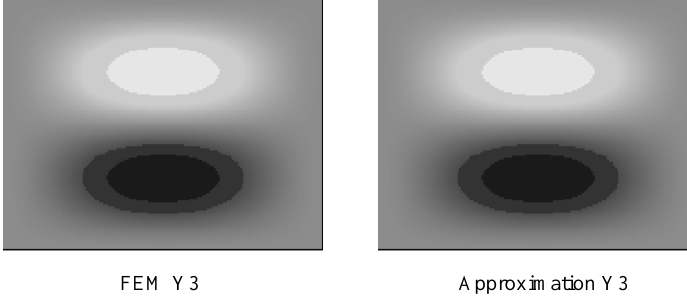
Fig. 6. Original FEM third mode (left) and approximation (right) for the Y3 damage case at position P1.